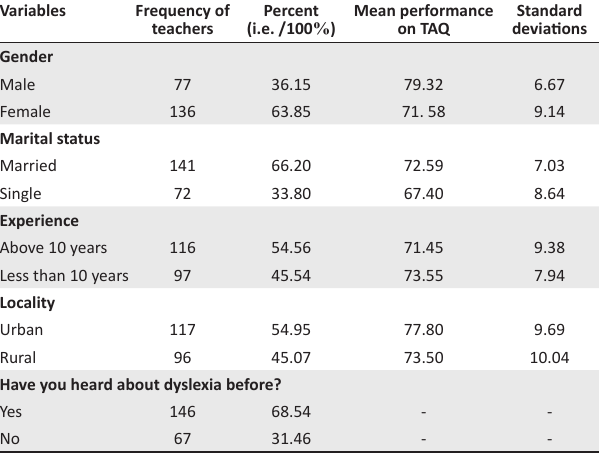
TABLE 1: Table of descriptive statistics showing demographic composition of the sample and scores on Teachers Awareness